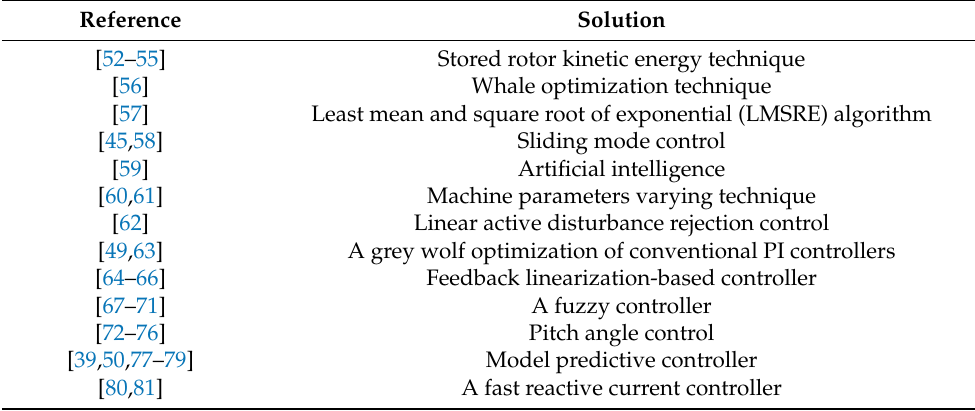
Table 1. Control approaches to enhance